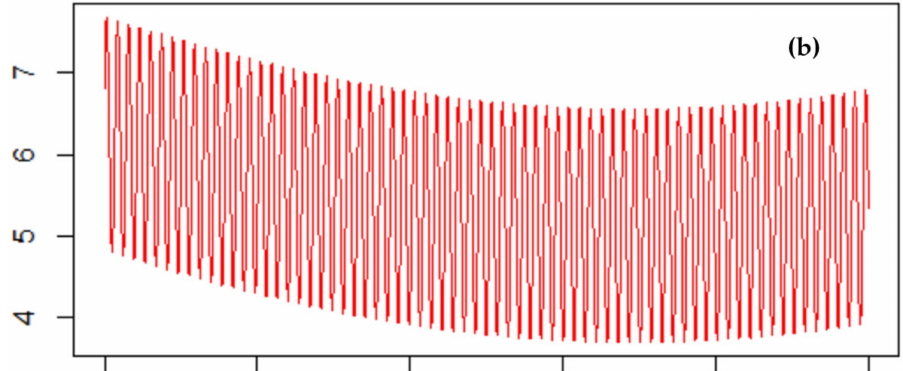
Figure 7. ( a ) The periodic component (shown in red) overlaid on the observed data series. ( b ) A portion of the periodic component (gold box in ( a )) shows the long period (annual) and short period (diurnal) variations.